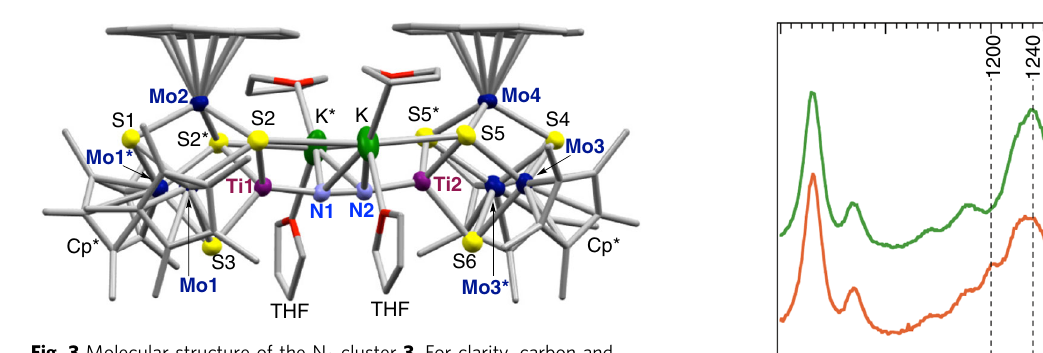
Fig. 3 Molecular structure of the N 2 cluster 3 . For clarity, carbon and oxygen atoms are drawn as capped sticks, while other atoms are drawn with thermal ellipsoids set at 50% probability. Color legend: C, gray; Mo, dark blue; Ti, purple; S, yellow; O, red; N, light blue; K, green. Selected bond